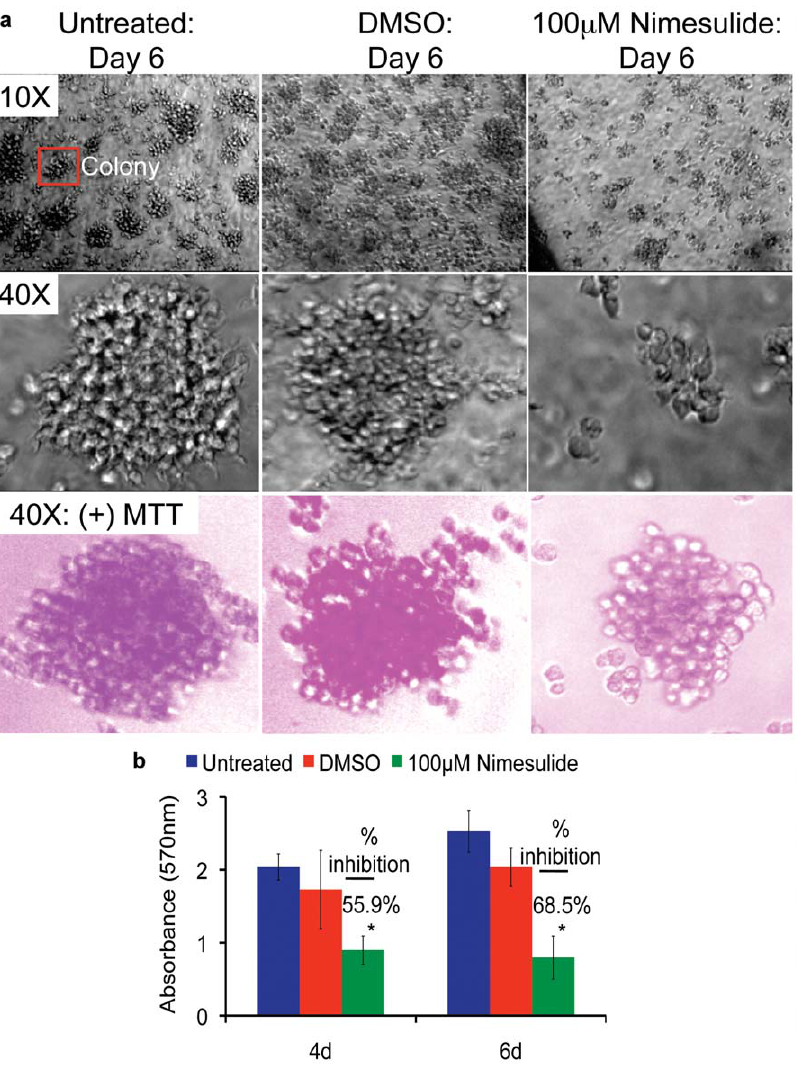
Figure 4. Effect of nimesulide on the transforming properties of BCBL-1 cells. ( a–b ) 5 6 10 5 BCBL-1 cells seeded with 100 m M nimesulide and colony formation was evaluated by a cell transformation assay. The cells were neither replenished with fresh media nor supplemented with the drugs. 6d (day 6) post-treatment with nimesulide, 10 6 and 40 6 bright field images were taken with (a; bottom panel) and without (a; top and middle panel) MTT and the proliferative capacity of cells within the colonies were measured using MTT at 4d (day 4) and 6d post treatment (b). Each experiment was done in triplicate, and each point represents the average 6 S.D. from three independent experiments. (*) p , 0.05, (**) p , 0.01. doi:10.1371/journal.pone.0024379.g004 cdk6, G1/S proteins cyclin E and cyclin A, and G2 proteins p- cdc2 and cdc25C. Compared to DMSO treatment, nimesulide